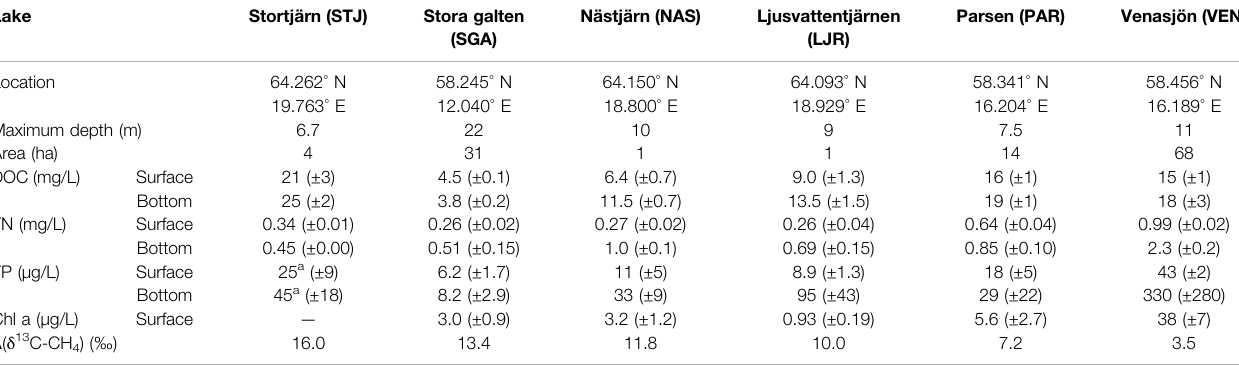
TABLE 1 | Characteristics of the lakes investigated in the present study.